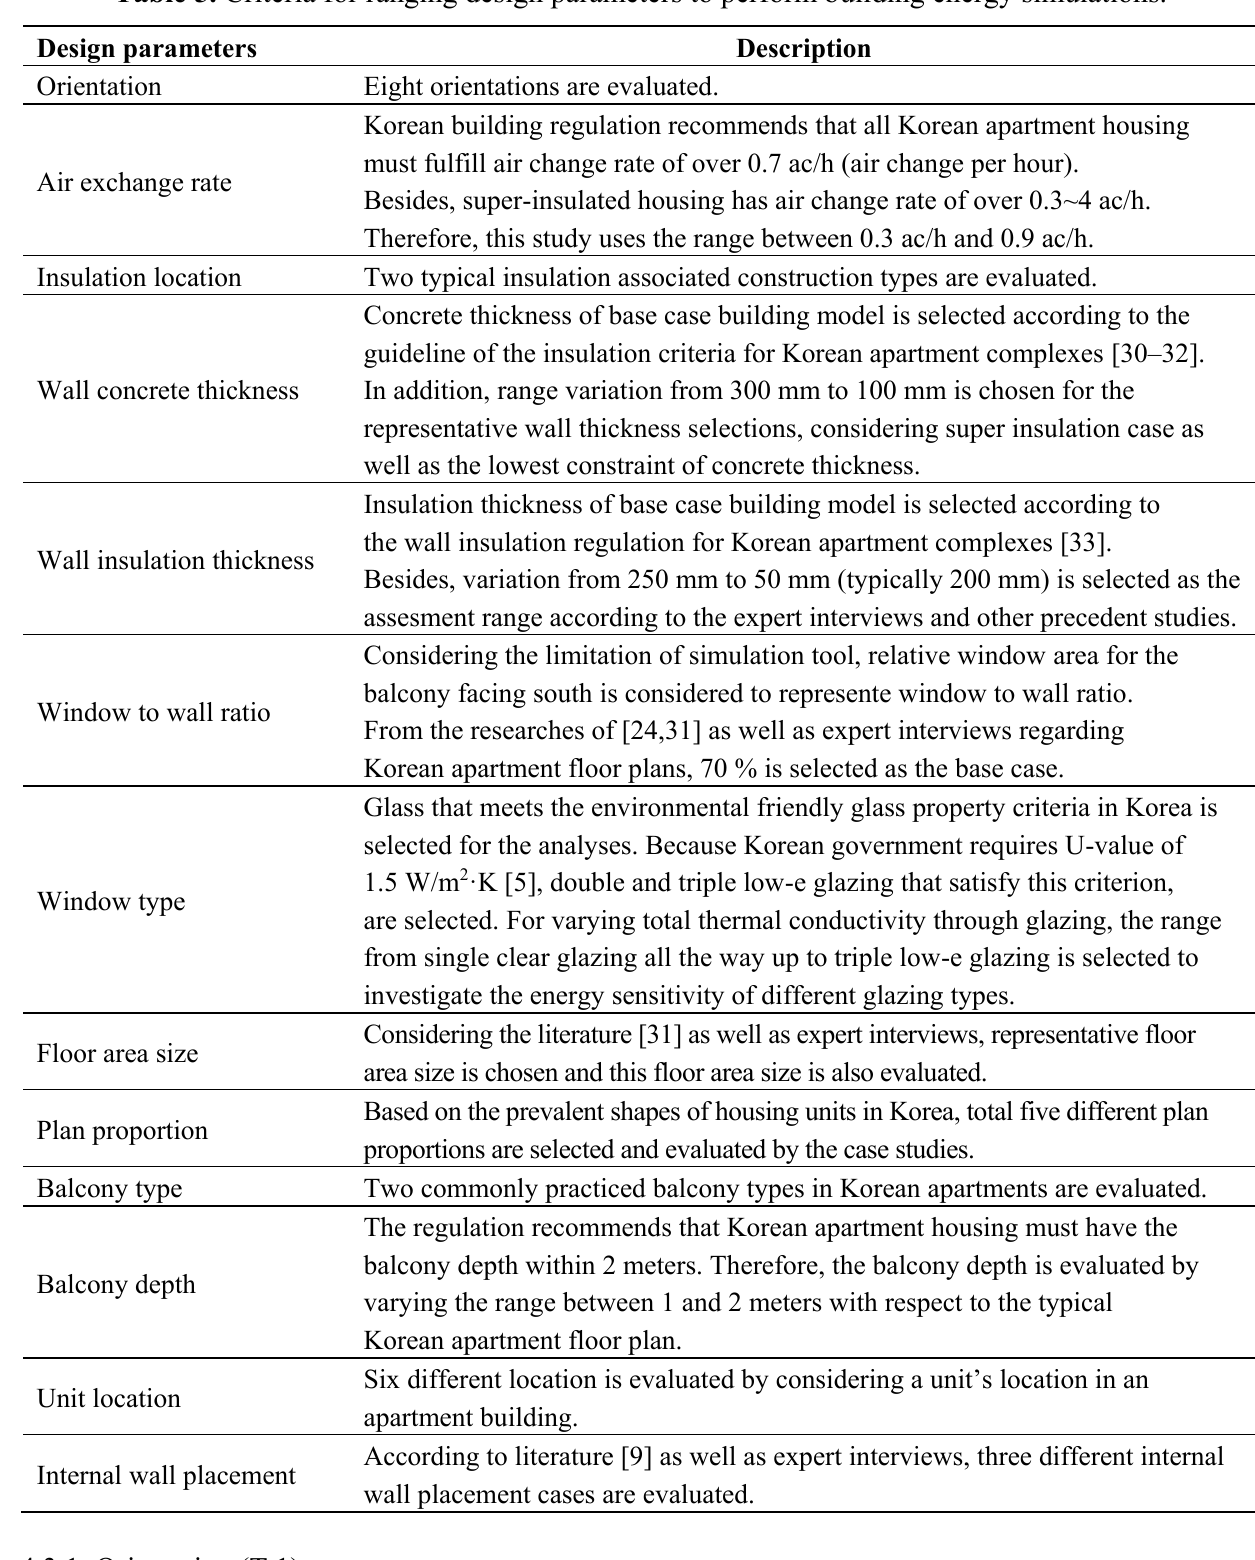
Table 5. Criteria for ranging design parameters to perform building energy